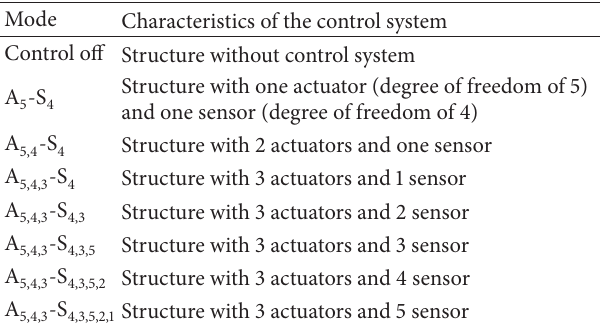
Table 4: Different control cases for the five-story shear building.